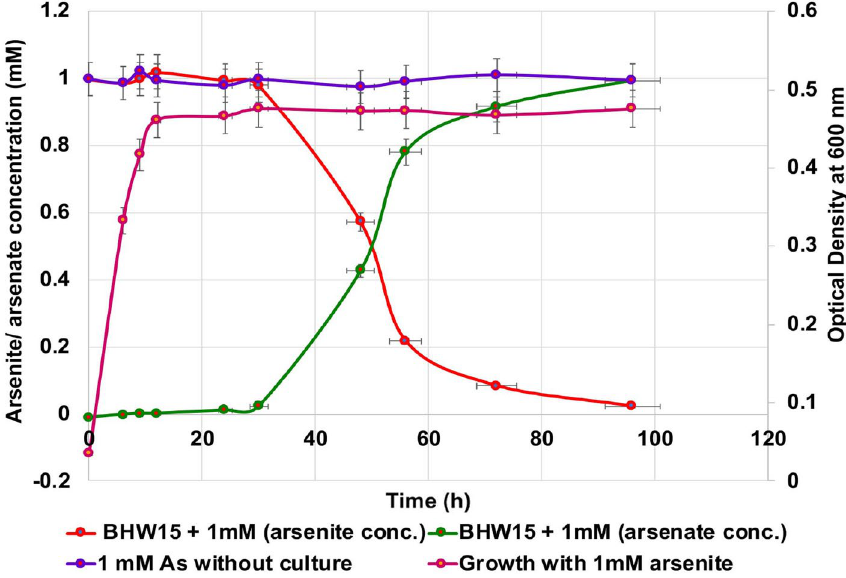
Figure 3. Growth curve and corresponding oxidation of As (III) to As (V) by Achromobacter xylosoxidans BHW-15. A. xlylosoxidans BHW-15 initiated arsenite conversion at late log phase and efficiently during stationary phase and it converted 1 mM of arsenite at 0.0224 mM/h rate. The error bar represents the deviation of the optical density (OD) measurement data of repeated